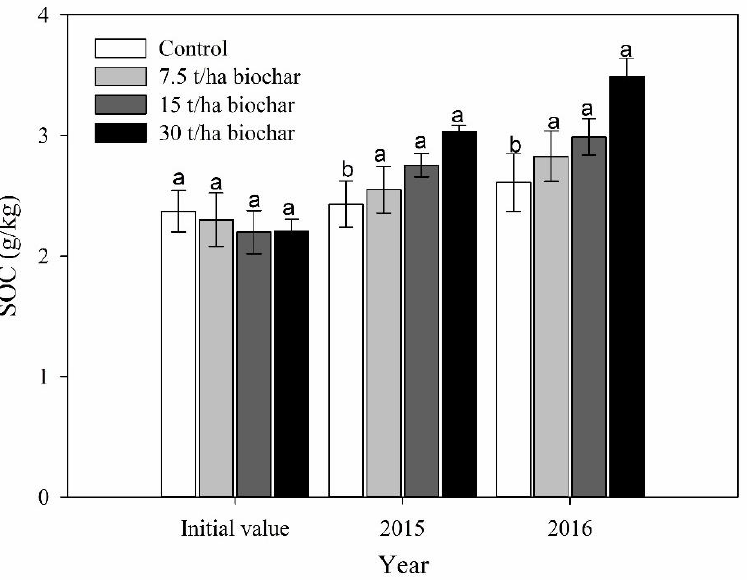
Figure 4. Soil organic carbon (SOC) as affected by biochar (BC) treatment. Values are means ± SD ( n = 3). Bars with different letters in each year are significantly different according to LSD at p < 0.05. The maize grain yield varied from 2.79 Mg ha − 1 in the control to 4.62 Mg ha − 1 in 30 Mg ha − 1 BC plot, and the barley yield varied from 2.65 Mg ha − 1 in CK to 3.13 Mg ha − 1 in 7.5 Mg ha − 1 BC treated plot (Figure 5). There were increases in the maize yield by 1.54 per hectare and 1.84 per hectare under 15 and 30 Mg ha − 1 biochar treatments compared to the control. The highest maize yield was found under the highest biochar-dose.